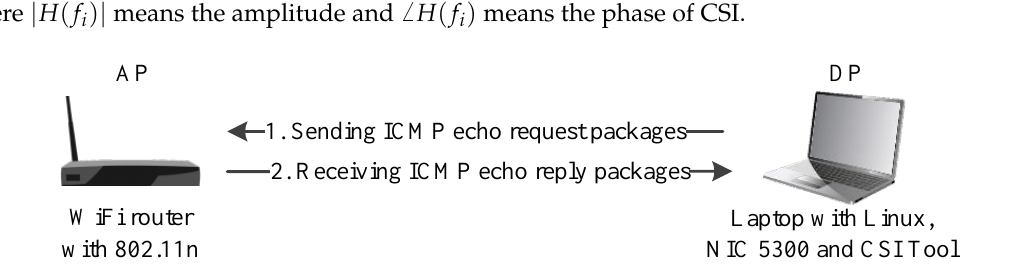
Figure 3. Channel state information (CSI) acquisition